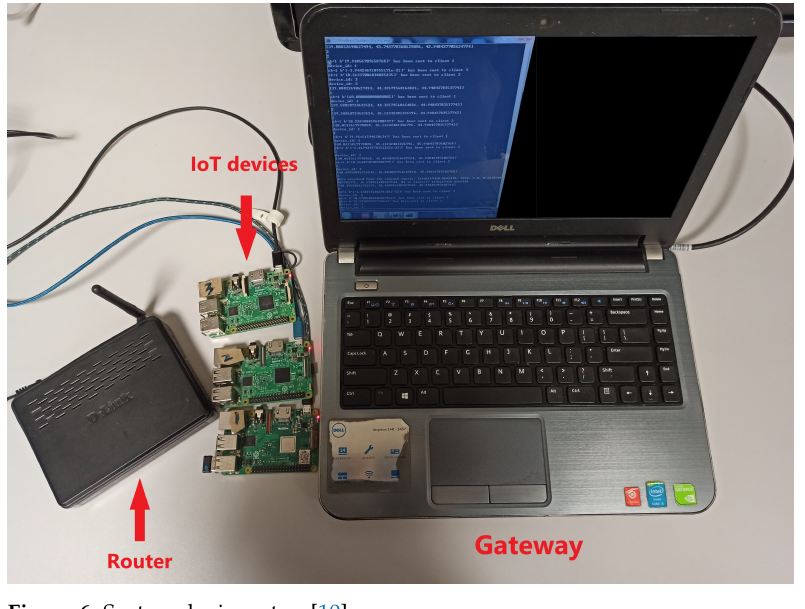
Figure 6. System device setup [10].